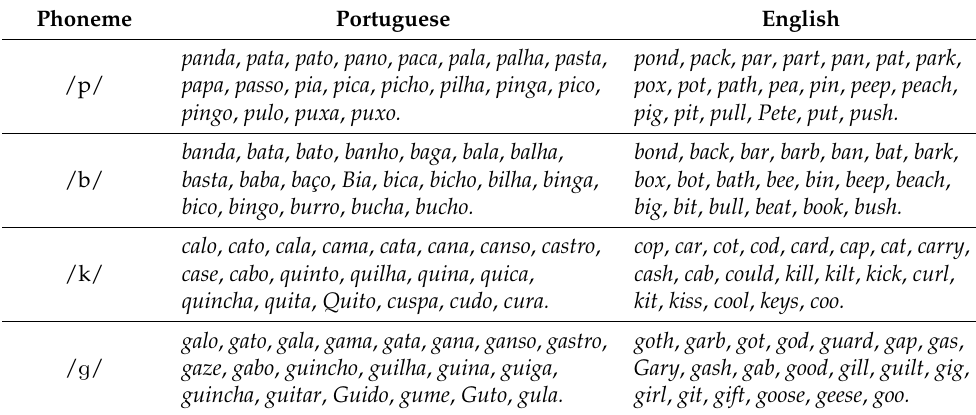
Table 1. Word lists produced by